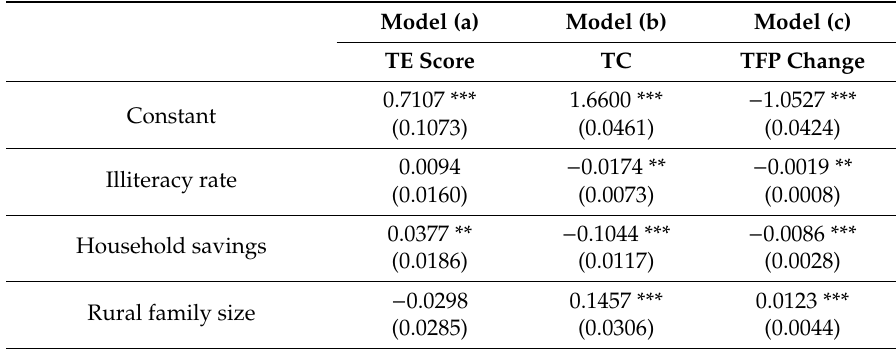
Table 5. Estimated results of factors affecting agricultural TE, TC, and TFP.